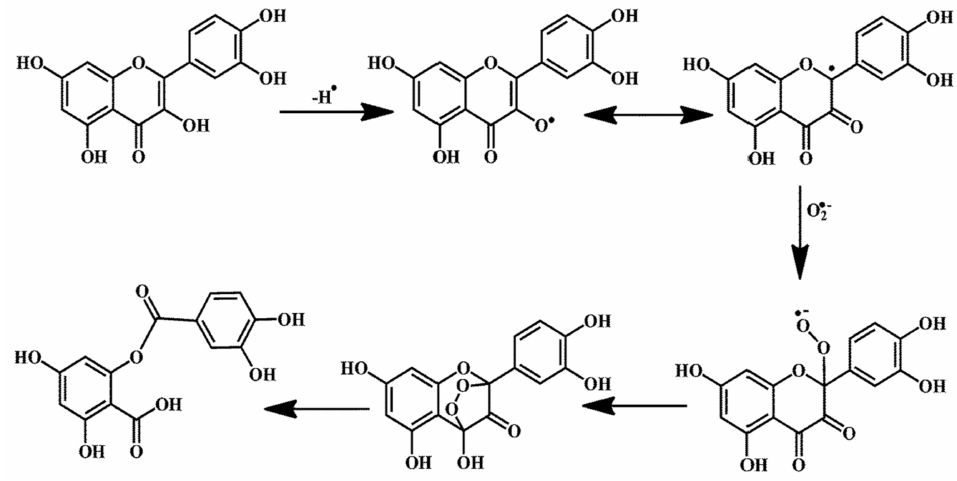
Figure 3. The radical scavenging mechanism of the superoxide anion by quercetin